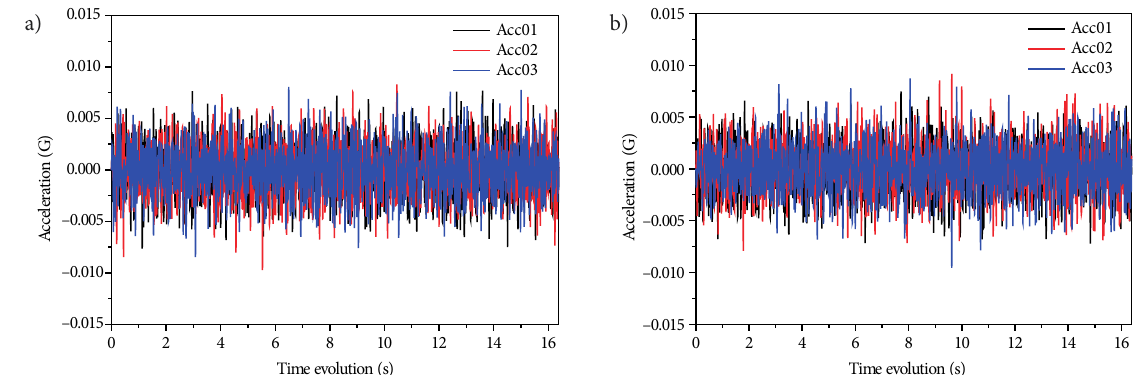
Fig. 10. Firsts 16s of the acceleration registered on Nossa Senhora das Dores Church: a) accelerations collected in X direction and b) accelerations collected in Y